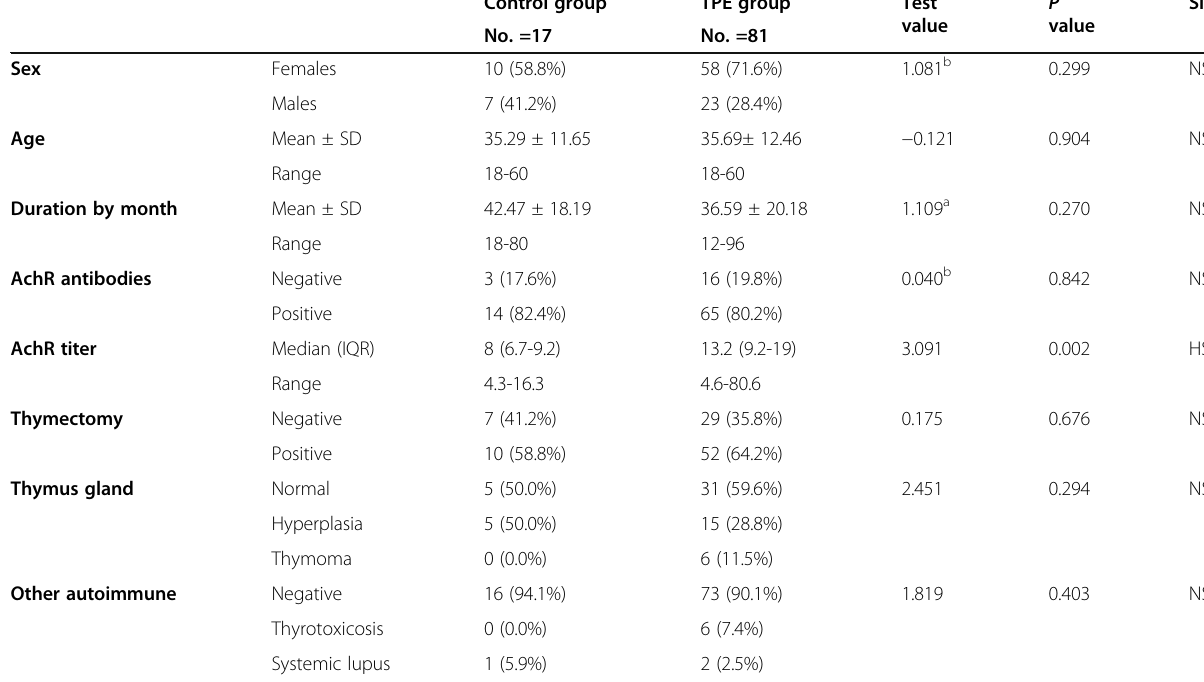
Table 1 Comparison between control group and TPE group regarding demographics, clinical, and laboratory criteria Control group TPE group